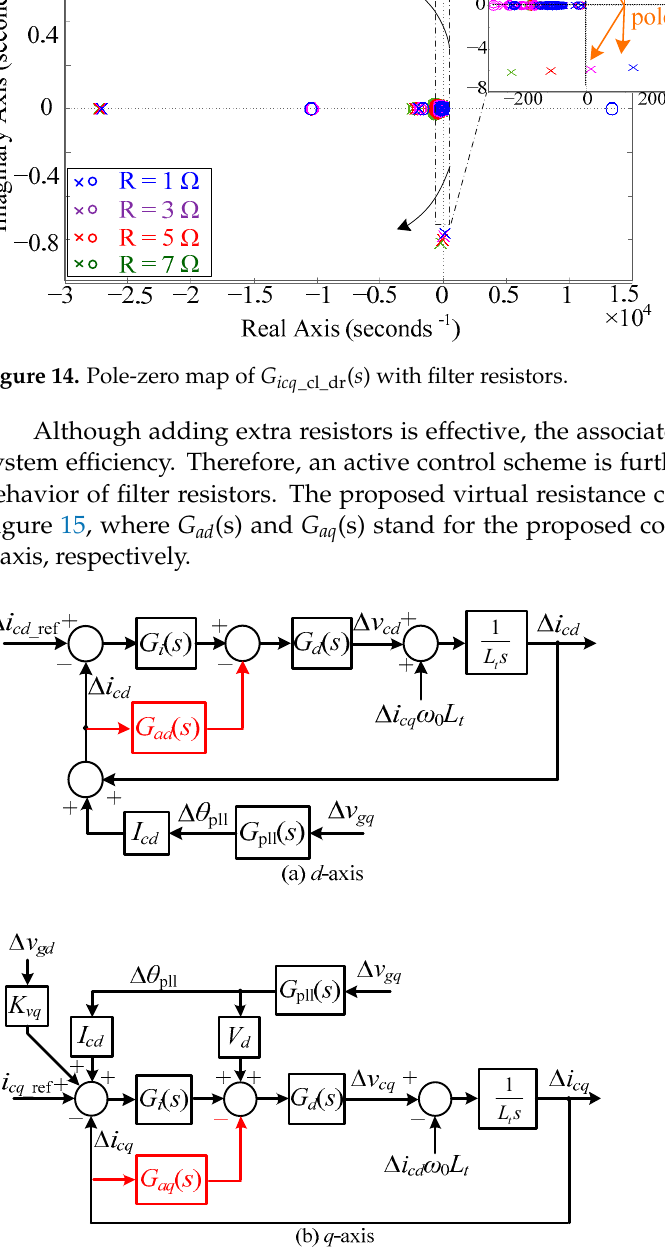
Figure 15. Proposed virtual resistance control scheme.